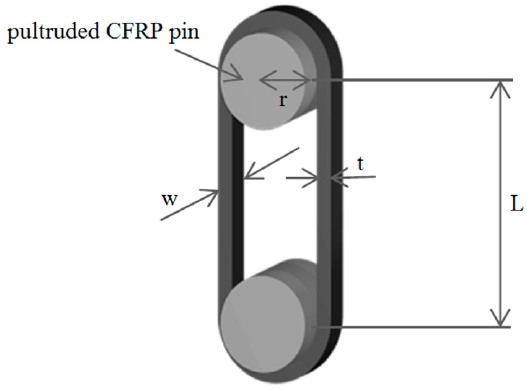
Figure 1. Schematic of a pin-loaded CFRP strap.